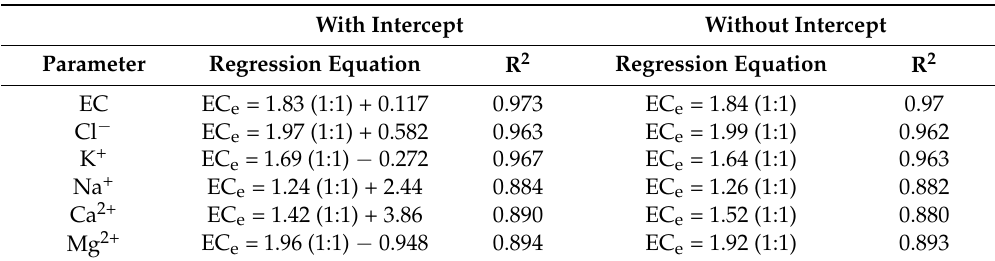
Table 4. Regression equations describing the relation between EC 1:1 and saturated paste extracts EC e (N = 198) and ion concentrations, along with the coefficients of determination (R 2 ) (N = 123). With Intercept Without Intercept Parameter Regression Equation R 2 Regression